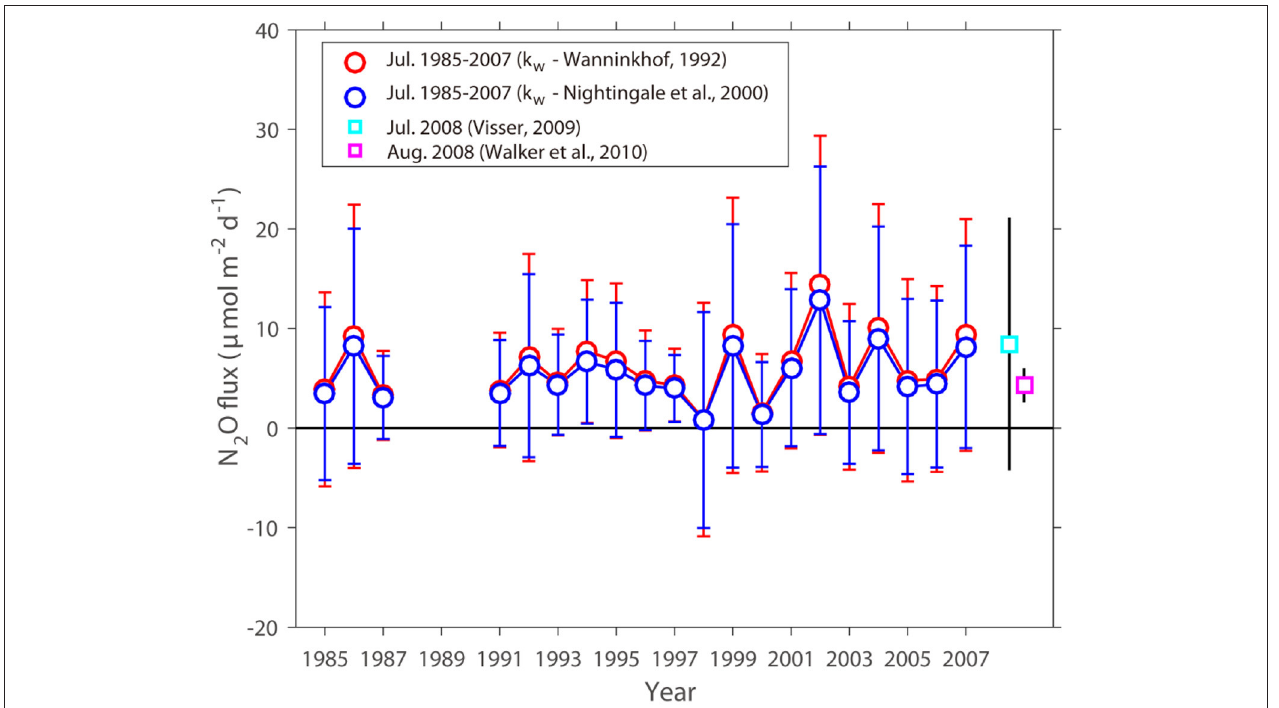
FIGURE 2 | Temporal variation of the estimated July N 2 O flux during the 1985–2007 study period (excluding 1988–1990) in the nGOM. Red circles are the estimated July N 2 O fluxes from this study using the gas transfer velocity ( k w ) of Wanninkhof (1992), blue circles are the estimated N 2 O fluxes from this study using k w of Nightingale et al. (2000), the cyan square is the measured N 2 O fluxes in July 2008 by Visser (2009), and the pink square is the measured N 2 O flux in August 2008 by Walker et al. (2010). Error bars indicate the standard deviations from the